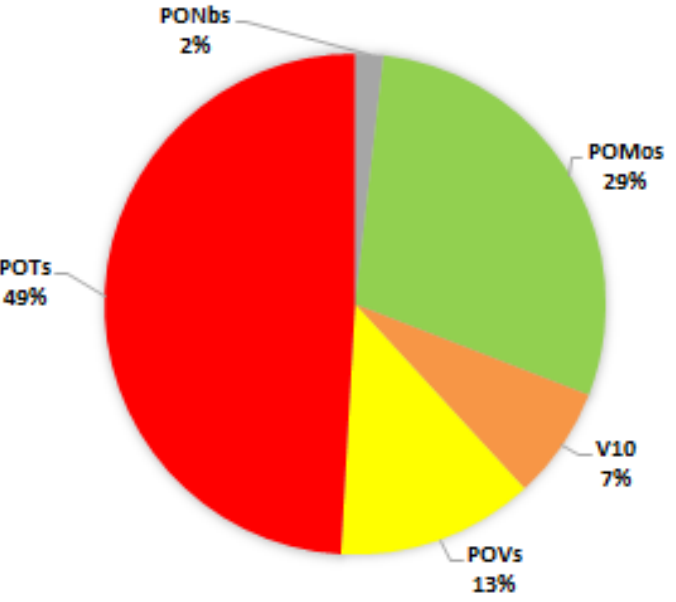
Figure 2. Studies for POMs tested against bacteria. Distribution, in percentage of the different POMs tested for antibacterial activity since 1996. POTs, polyoxotungstates; POMos, polyoxomolybdates; POVs, polyoxovanadates; PONbs, polyoxoniobates. POTs, such as [KAs 4 W 40 O 140 ] 27 − , (abbreviated As 4 W 40 ) and [P 2 W 18 O 62 ] 6 − (abbreviated